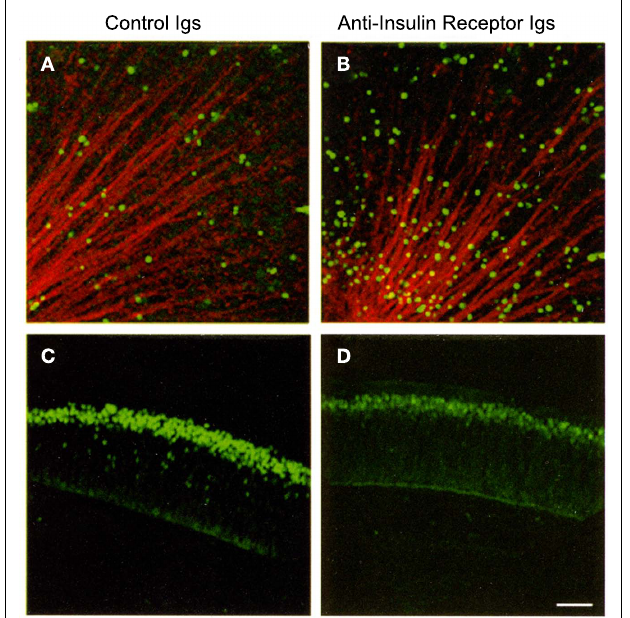
FIGURE 5 | Photoreceptor cell death is delayed and the photoreceptor layer is preserved in rd10 mice expressing proinsulin. Cell death was visualized byTUNEL in P25 flat-mount retinas of rd10 and hPi/ rd10 transgenic mice [in green (A,B) ]. Retinal cytoarchitecture was visualized with Alexa 488-peanut agglutinin [green-labeled cones (C,D) ] and DAPI staining [blue (C,D) ; arrow indicates photoreceptor rows] in P32 retinal sections. Reproduced from Corrochano et al. (2008) with permission; ©2008,The Association for Research inVision and Ophthalmology. Scale bars = 200 μ m in (A,B) and 25 μ m in (C,D)